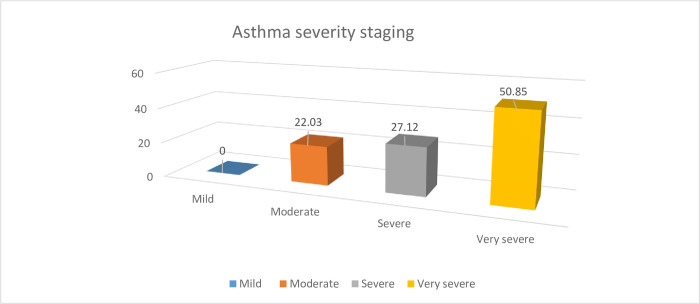
Clinical staging for asthma using GINA guideline at JMC, April -September, 2019.